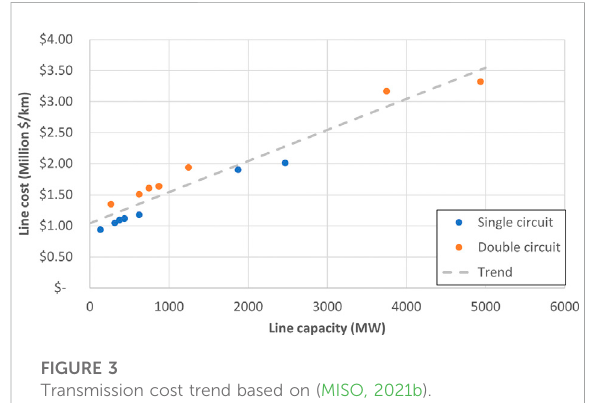
FIGURE 3 Transmission cost trend based on (MISO,